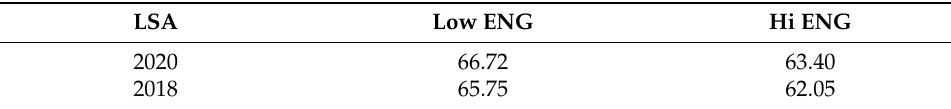
Table 6. Mean values for moderating effect of COVID-19 ( n = 3879).